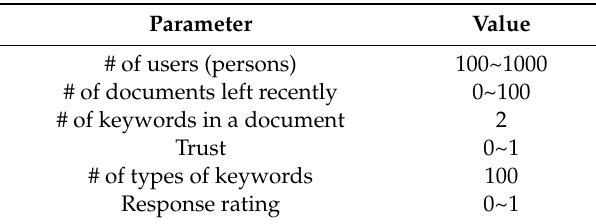
Table 2. Performance evaluation